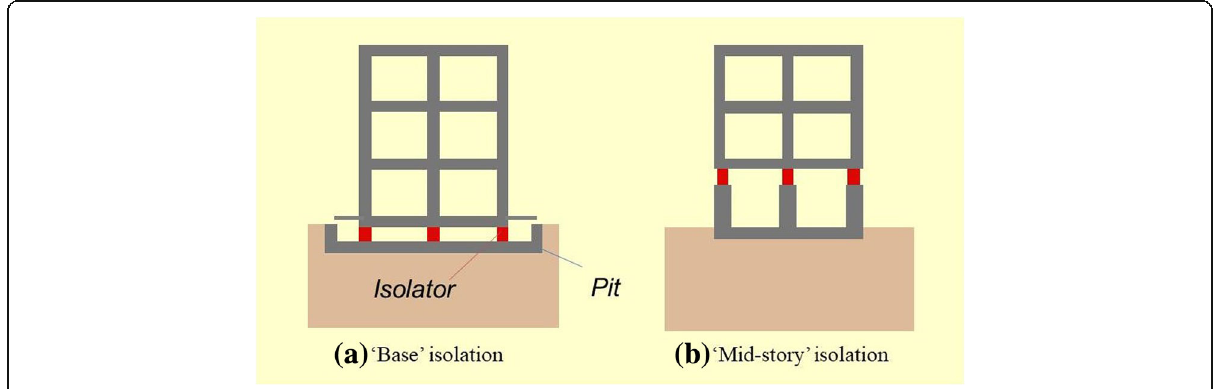
Fig. 7 Comparison of two furnished rooms set on a shaking table